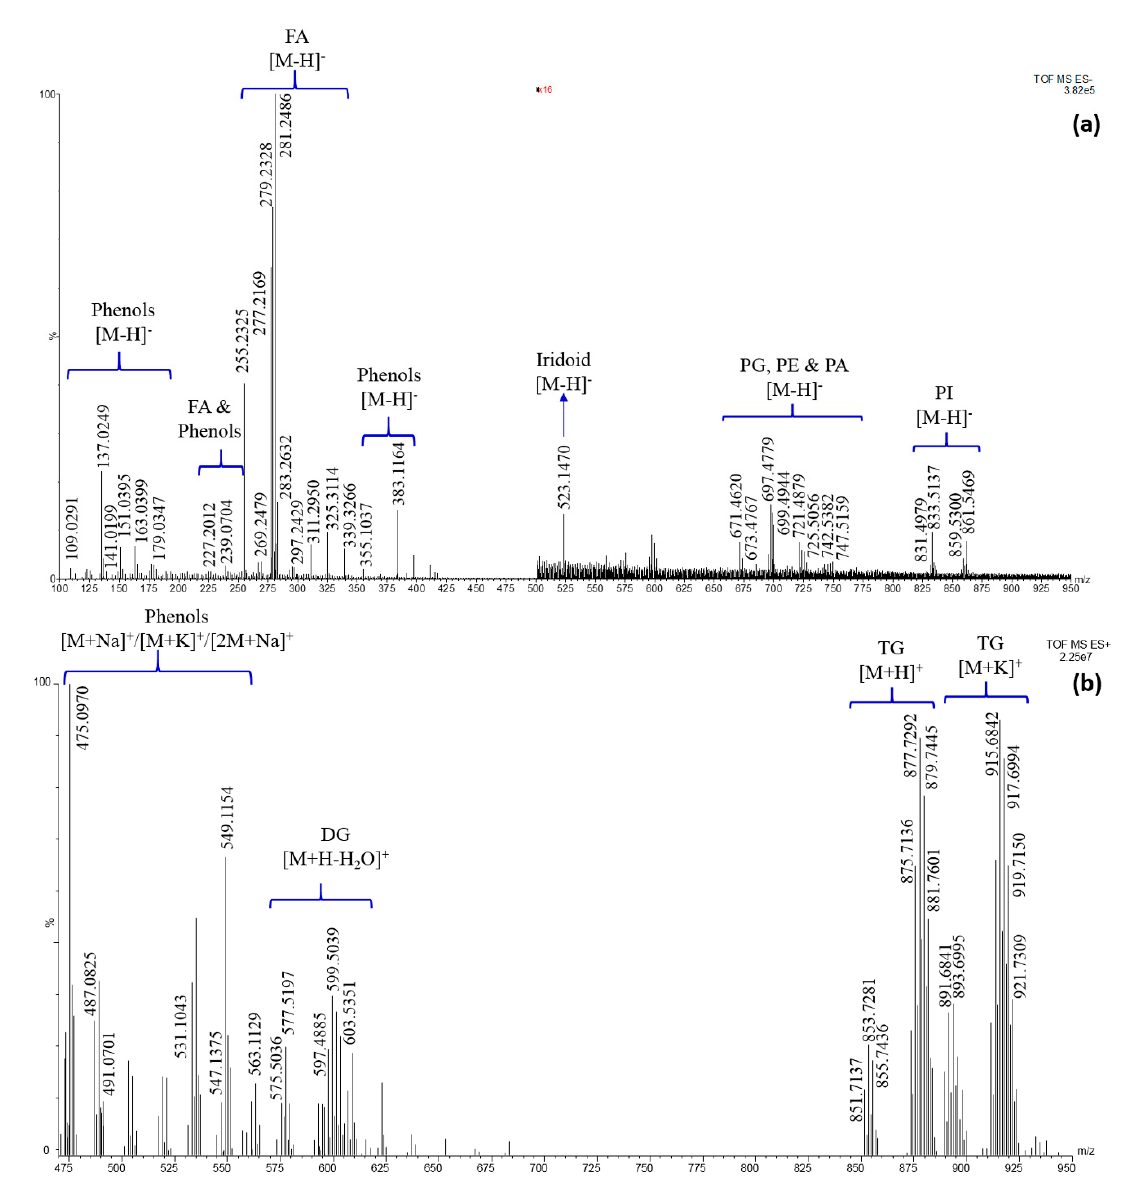
Figure 2. ( a )REIMS(-)spectrumoverthemassrange100–950 m / z —the500–950 m / z regionwasmagnifiedofa Figure 2. ( a ) REIMS (-) spectrum over the mass range 100–950 m/z – the 500–950 m/z region was 16factor;( b )REIMS( + )spectrumoverthemassrange470–950 m / z . Aclassidentificationisalsoreported,along magnified of a 16 factor; ( b ) REIMS (+) spectrum over the mass range 470–950 m/z . A class with the ion type detected. DG = diglyceride; FA = fatty acid; MG = monoglyceride; PA = phospatidic identification is also reported, along with the ion type detected. DG = diglyceride; FA = fatty acid; MG acid; PE = phosphatidylethanolamine; PG = phosphatidylglycerol, PI = phosphatidylinositol; = monoglyceride; PA = phospatidic acid; PE = phosphatidylethanolamine; PG = phosphatidylglycerol, TG = PI = phosphatidylinositol; TG = triglyceride.